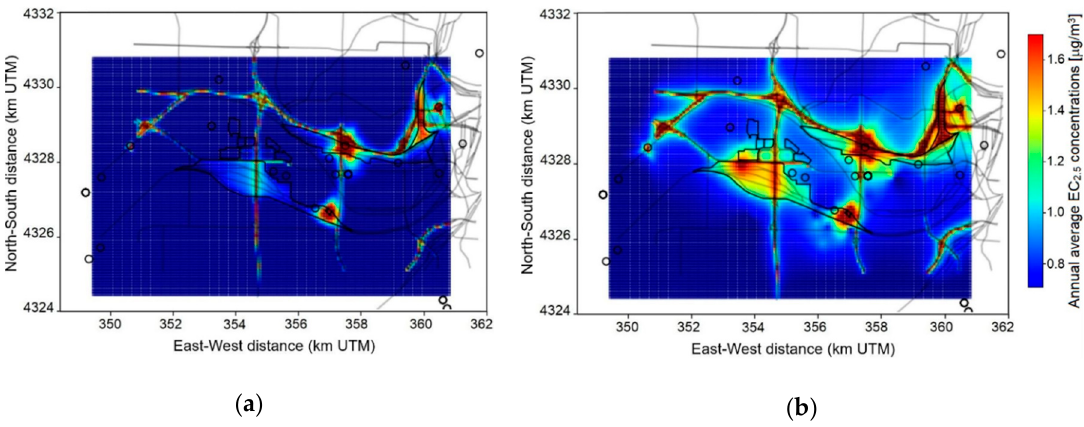
Figure 8. Map of EC 2.5 concentrations based on dispersion modeling ( a ) and based on data fusion ( b ).